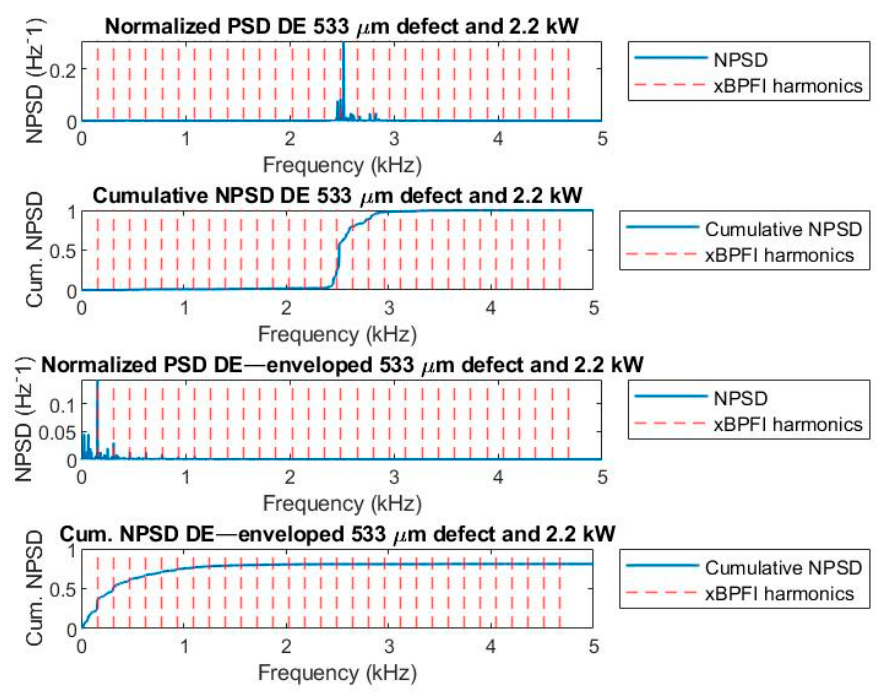
Figure 17. NPSD and cumulative NPSD nonenveloped and enveloped signals: vibration signal.